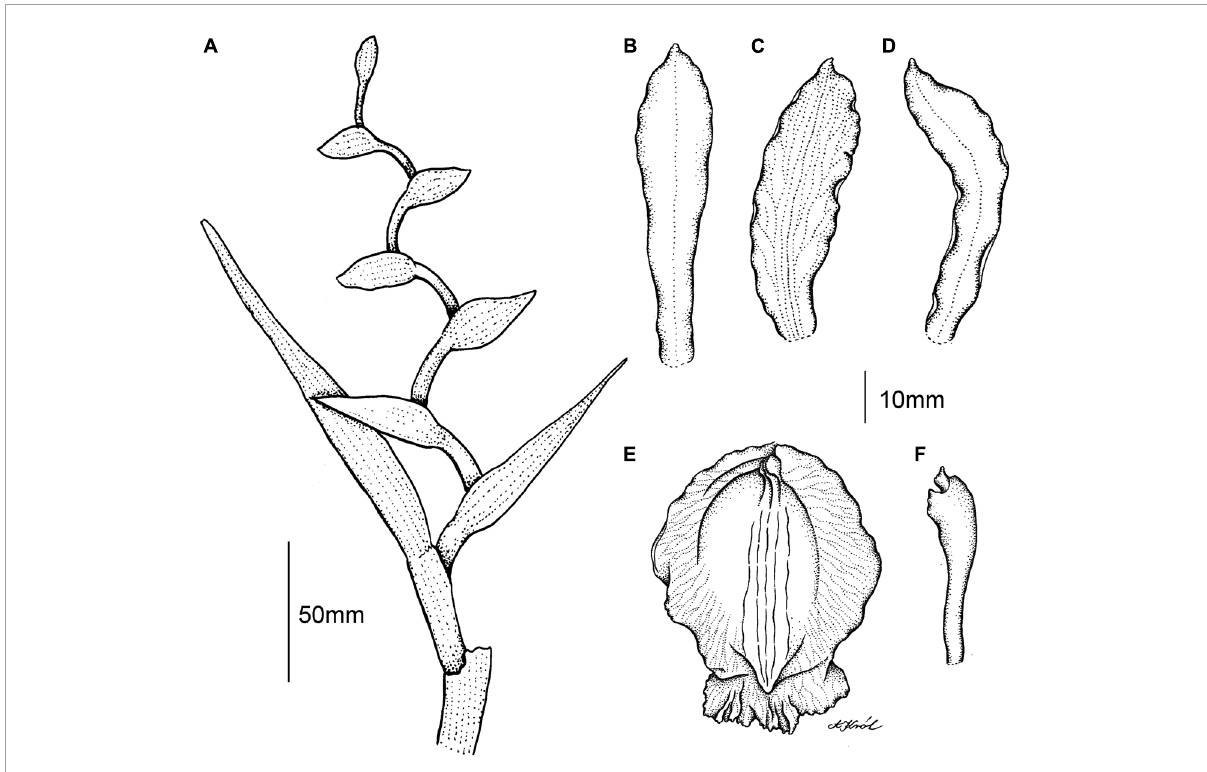
FIGURE9 Sobralia ruckeri Linden & Rchb. f. (A) apical part of stem with inflorescence, (B) dorsal sepal, (C) petal, (D) lateral sepal, (E) lip, and (F) gynostemium, side view [drawn by P. Baranow (A) and A. Król (B–F) from the holotype].